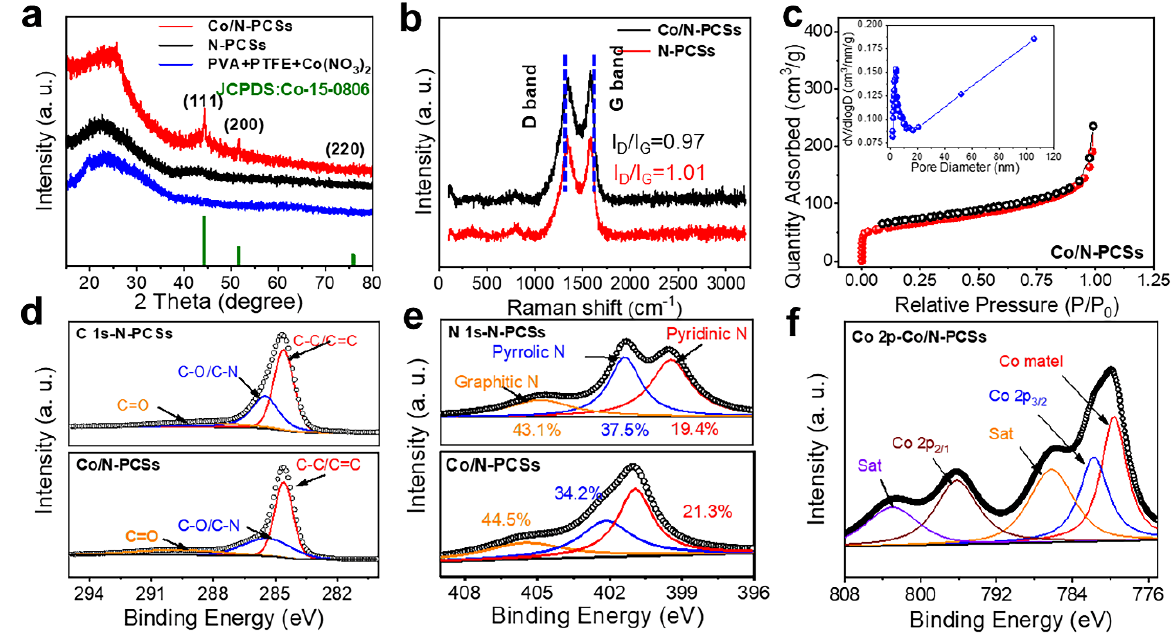
Figure 3. ( a ) XRD patterns of Co/N-PCSs, N-PCSs, and PVA+PTFE+Co (NO 3 ) 2 , ( b ) Raman spectra of N-PCSs and Co/N-PCSs, ( c ) N 2 sorption isotherms and pore distributions of Co/N-PCSs, ( d ) High- resolution C 1s of both samples, ( e ) High-resolution N 1s of both samples, ( f ) High-resolution Co 2p of Co/N-PCSs.